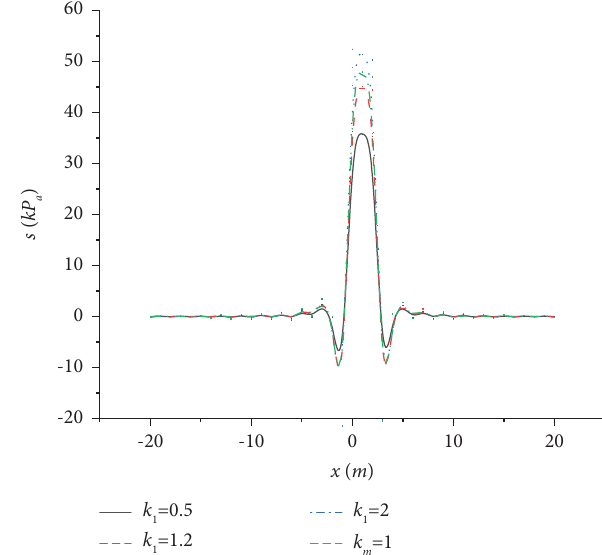
Figure 8: Contact stress curves in x- direction due to E